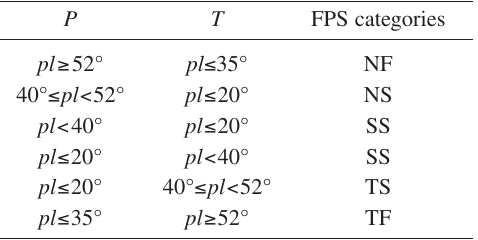
Table VI. Fault-plane solution categories based on different plunge ranges for P - and T -axes for the WSM, as determined according to Zoback